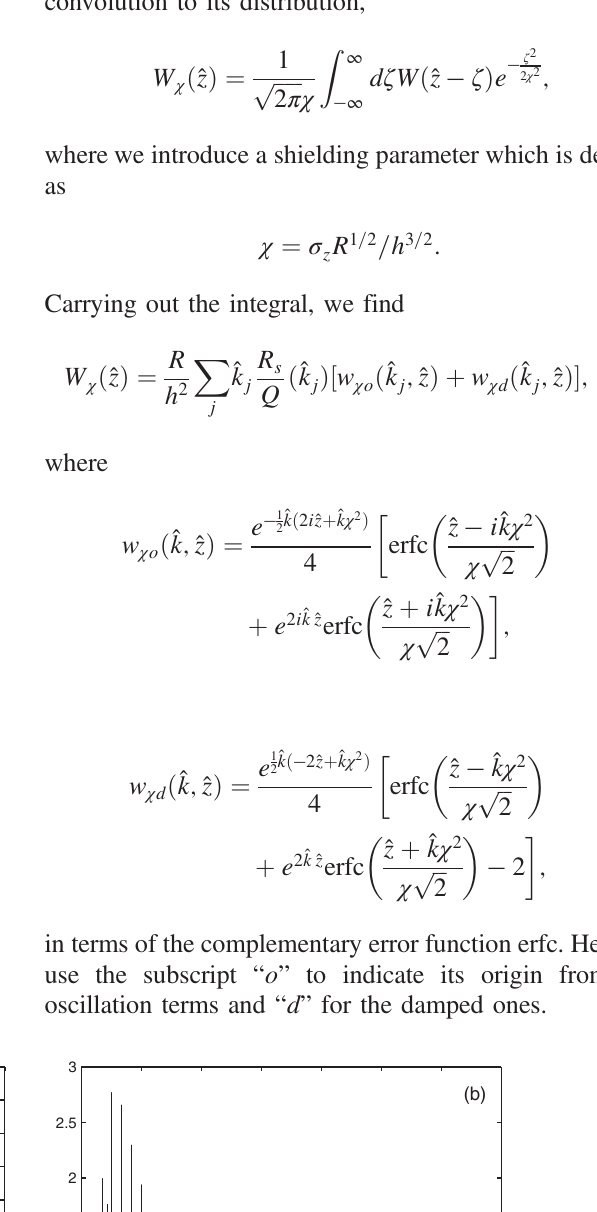
=Q for the resonances as a function of FIG. 4. R s (b) A ¼ 3 with 204